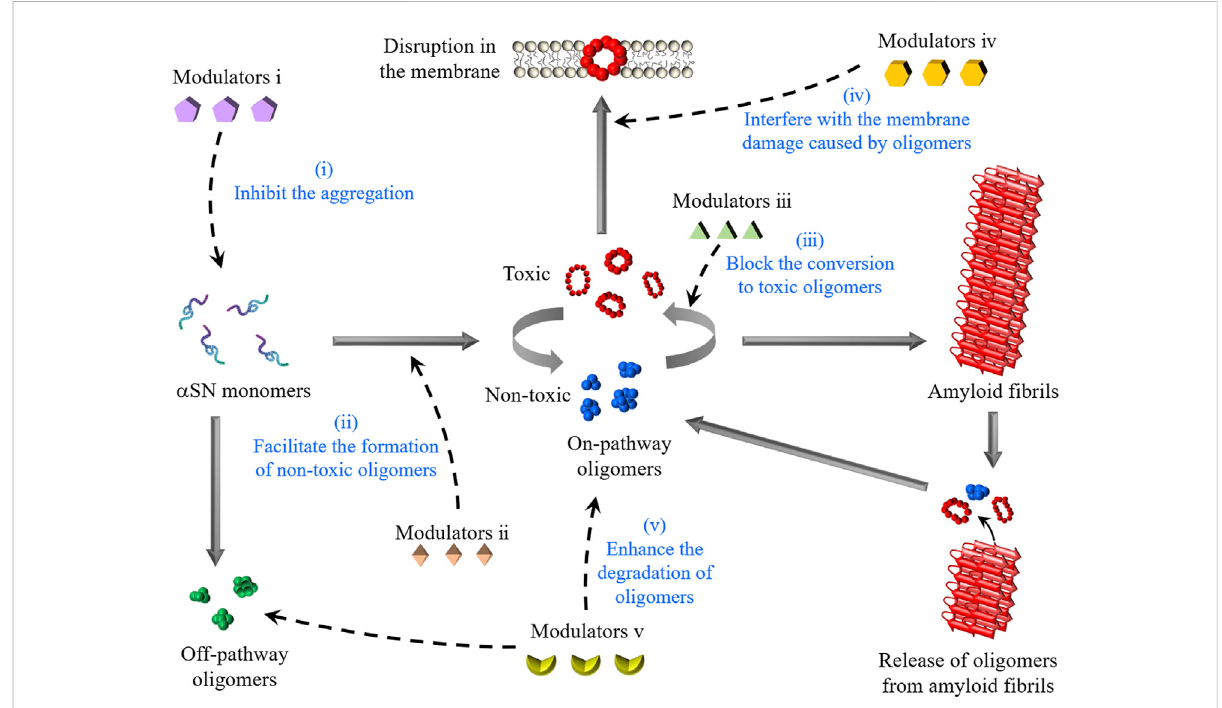
FIGURE 2 Schematicrepresentationoftheformationof α SNoligomersandinterventionstrategies. α SNoligomersaregeneratedthroughtheaggregation of monomers or the disaggregation of amyloid fi brils. The modulators described in this review interfere with the toxicity of α SN oligomers by fi ve molecular mechanisms: (1) the inhibition of α SN amyloid formation, (2) the enhanced formation of non-toxic oligomers, (3) the stabilization of non- toxic oligomers for blocking their conversion to toxic oligomers, (4) the displacement of toxic oligomers from cell membranes, and (5) the enhancement of the degradation of